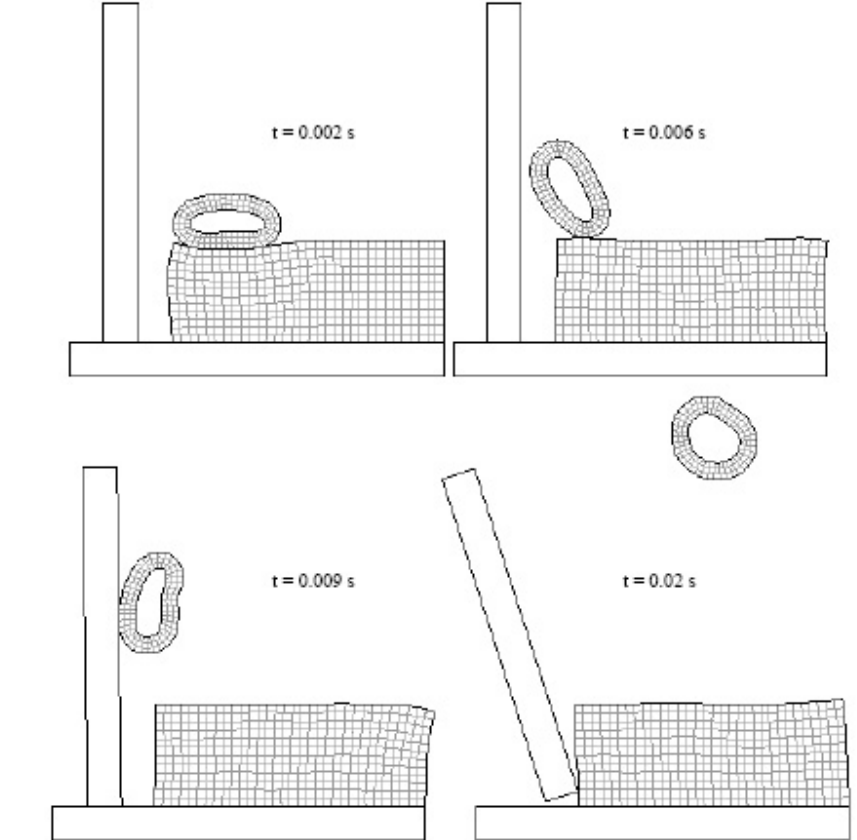
Fig. 7. Deformed configurations at different times.